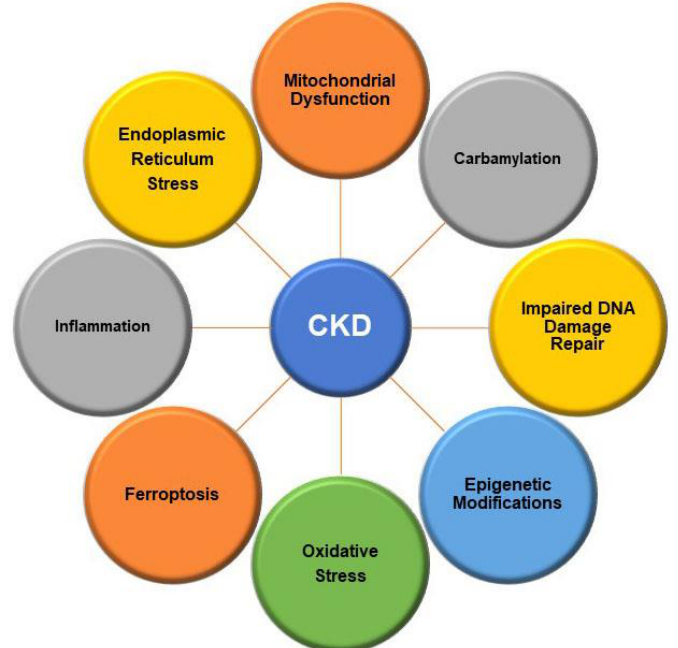
Figure 1. Molecular mechanisms involved in pathogenesis and progression of chronic kidney disease (CKD). CKD is a complex disease that involves dysregulation of multiple physiological processes. This diagram is meant to show the major molecular mechanisms that promote pathogenesis of CKD with the understanding that there are many other mechanisms that may also be involved in this